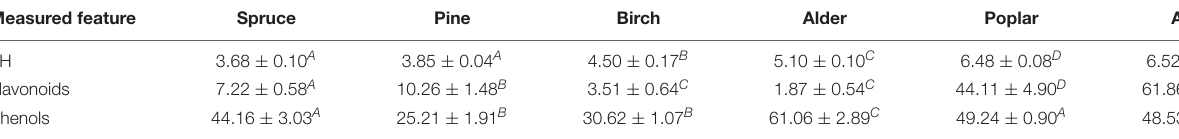
TABLE 4 | pH of samples and a content of phenolic compounds and flavonoids (mg/g) in bark of studied phorophytes.